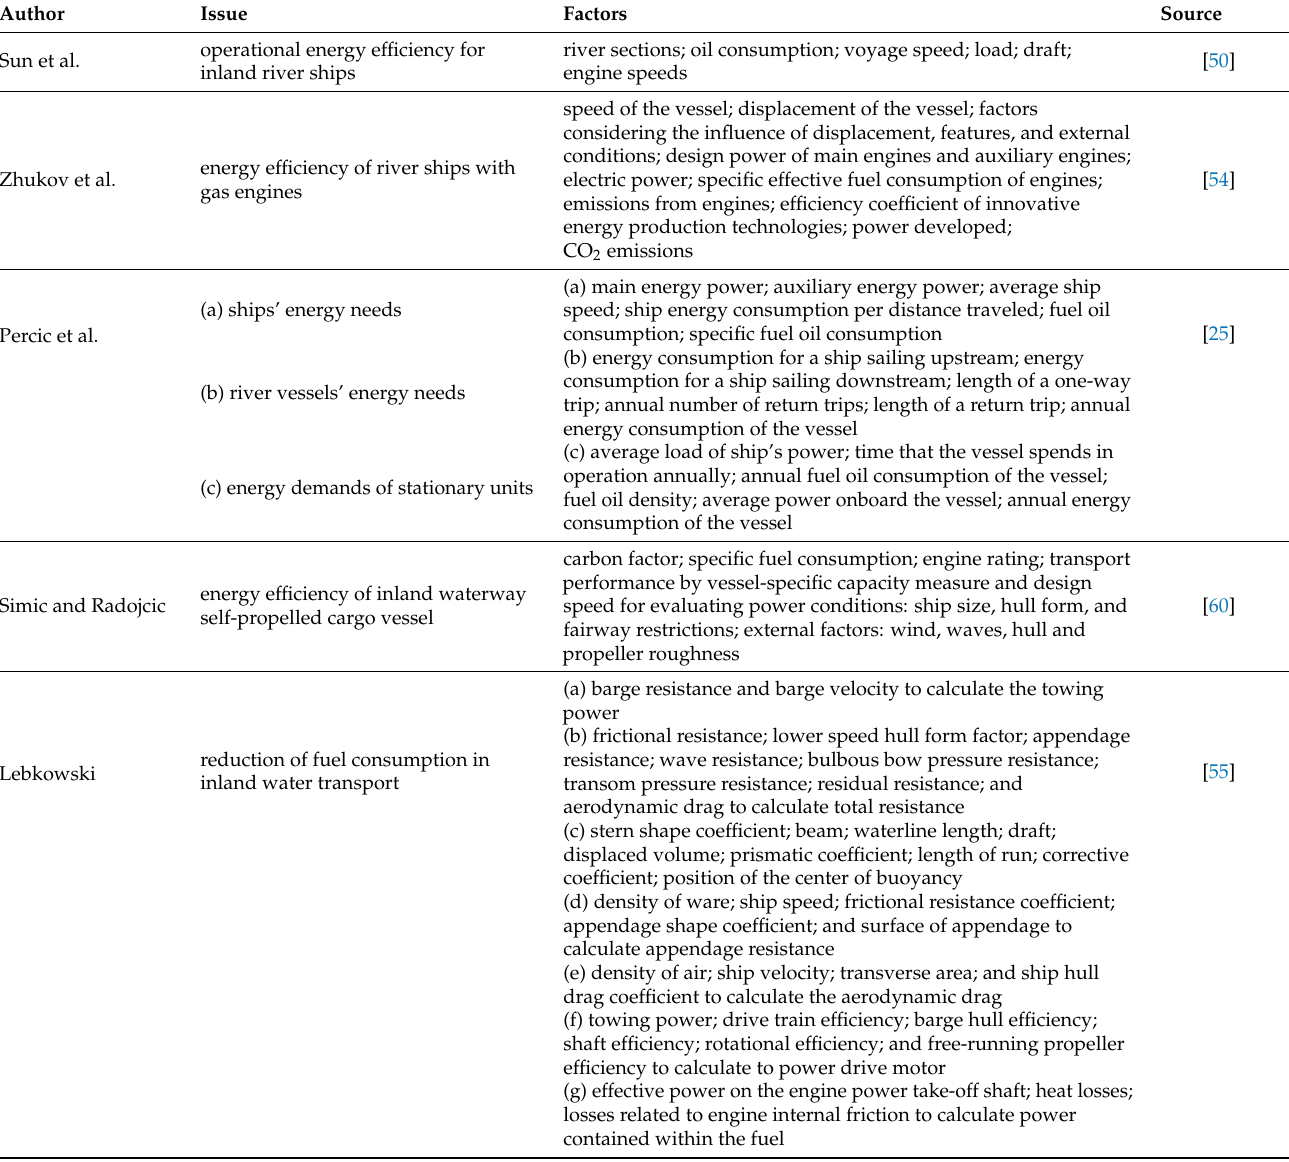
Table 2. Overview of factors related to issues on energy consumption in inland waterway transport from the point of view of